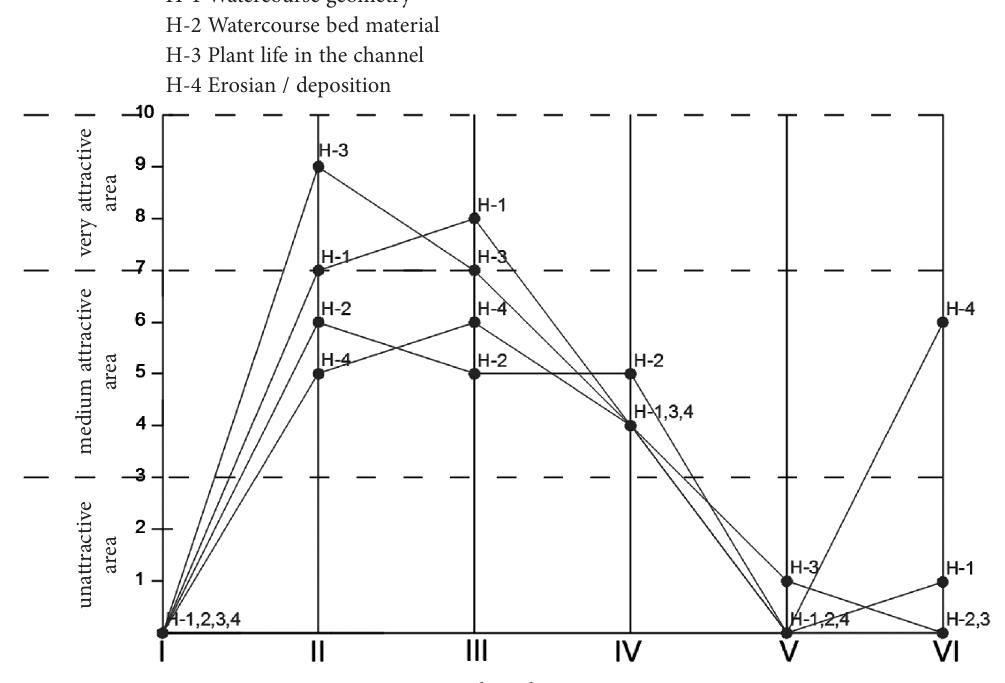
Figure 3. Values for hydromorphological elements (H) in the LSHM Method assessment of the Skawinka river valley (drawing from the author’s private archives)